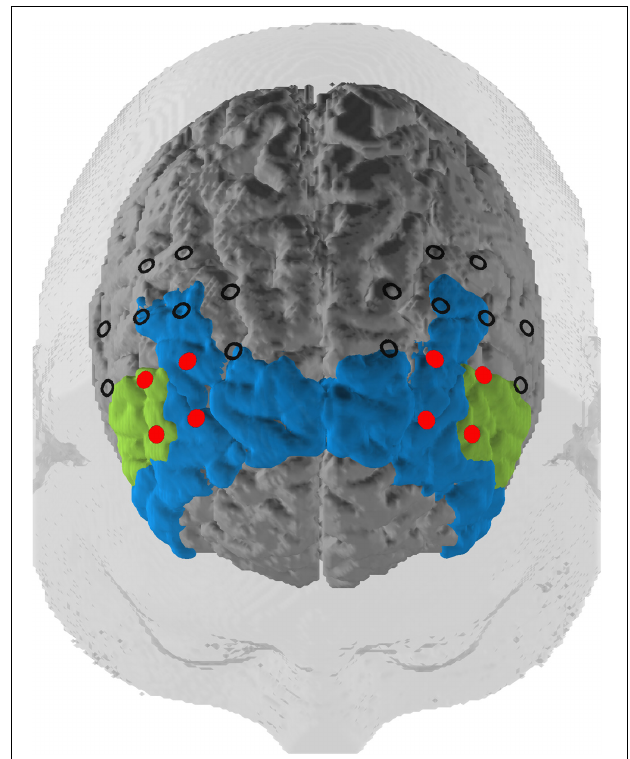
FIGURE 2 | Probeset. Depiction of the target regions of the neurofeedback training (in red) and the rest of the optode array. The optodes cover a space mostly located in the dlPFC (blue, Brodmann areas 9 and 46) but also extending to the inferior frontal gyrus (green, Brodmann area 45) according to a virtual registration method (see subsection Functional Near-Infrared Spectroscopy